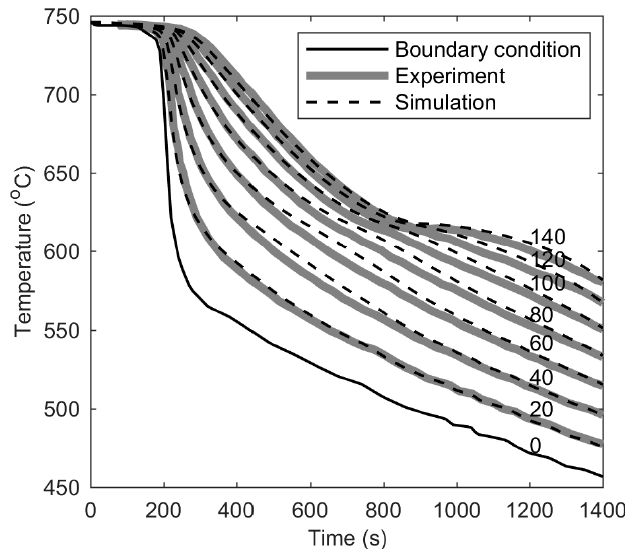
Figure 11. Experiment curves versus predicted cooling curves at labeled distances started from the bottom of the Al-7wt%Si ingot.